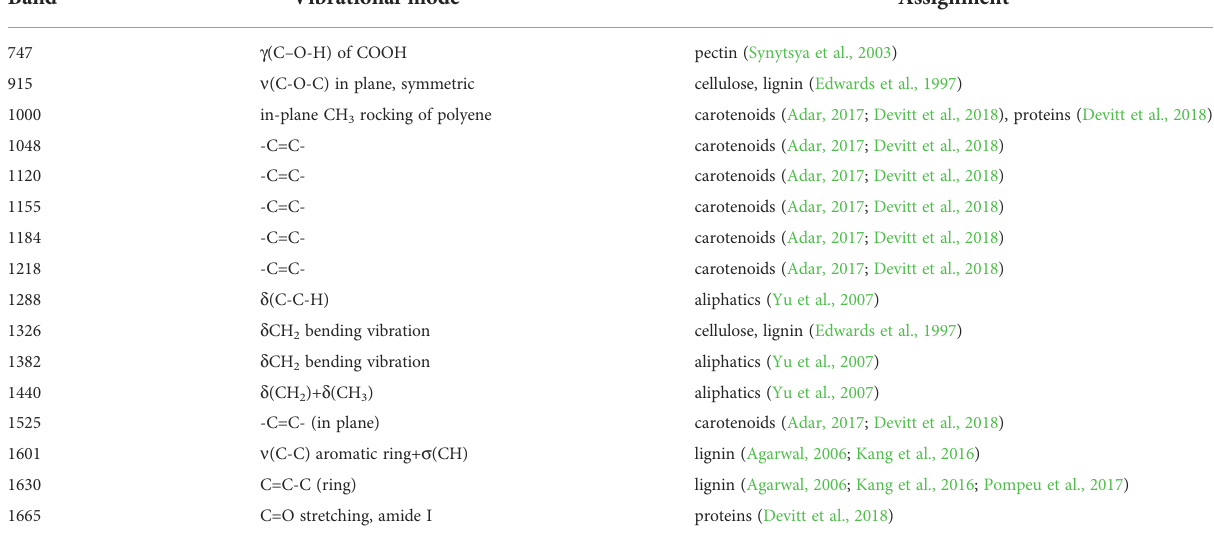
TABLE 1 Vibrational band assignments for wheat leaf